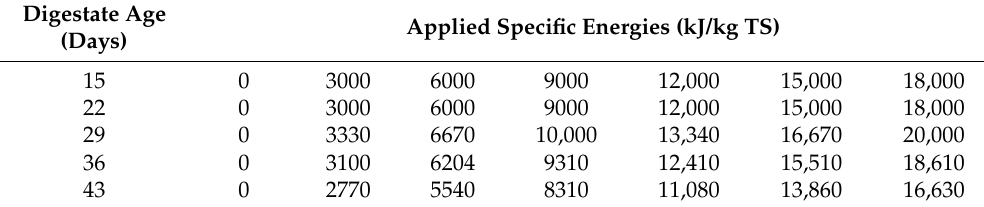
Table 1. Specific energy (SE) applied to the digestates per simulated digestate